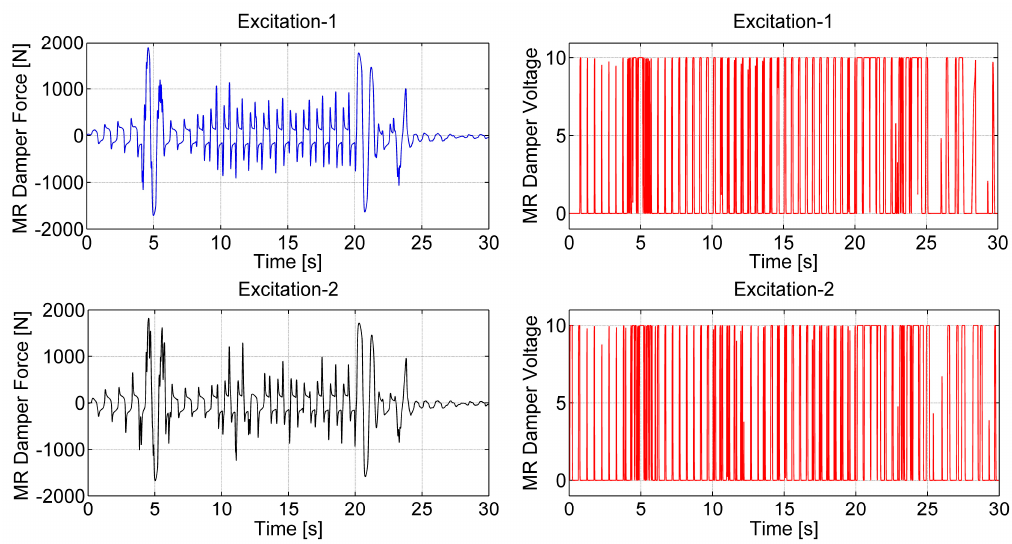
Figure 12. The MR damper force (left) and voltage curves (right).